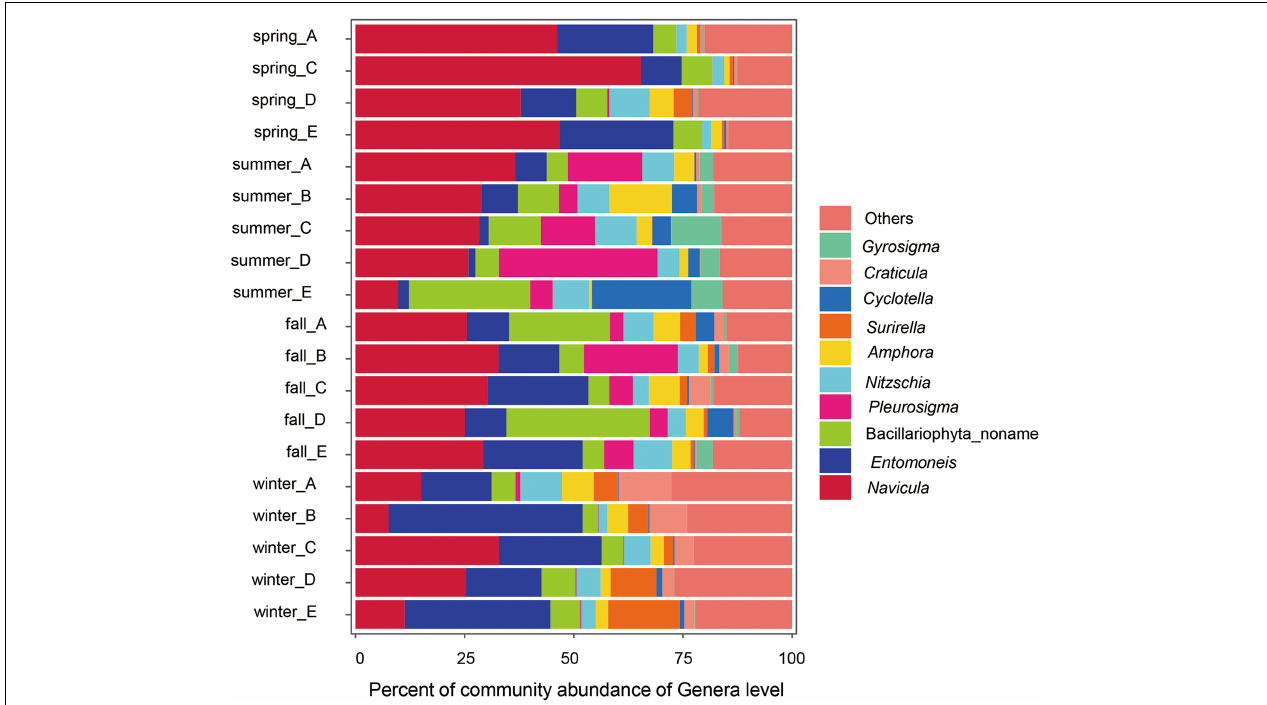
FIGURE 4 | Compositions of dominant benthic diatom in each site at the Genera